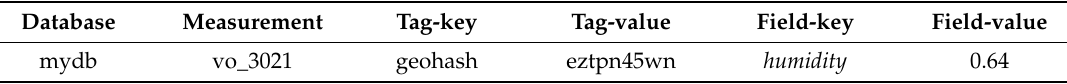
Table 4. Storage Mechanism of